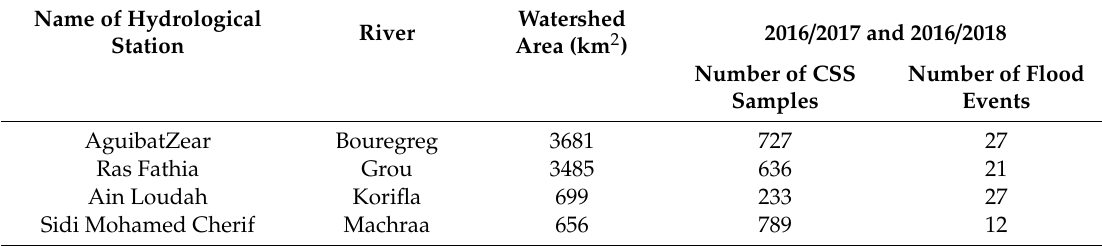
Table 4. Number of concentration of suspended solids (CSS)samples and floods events per station.